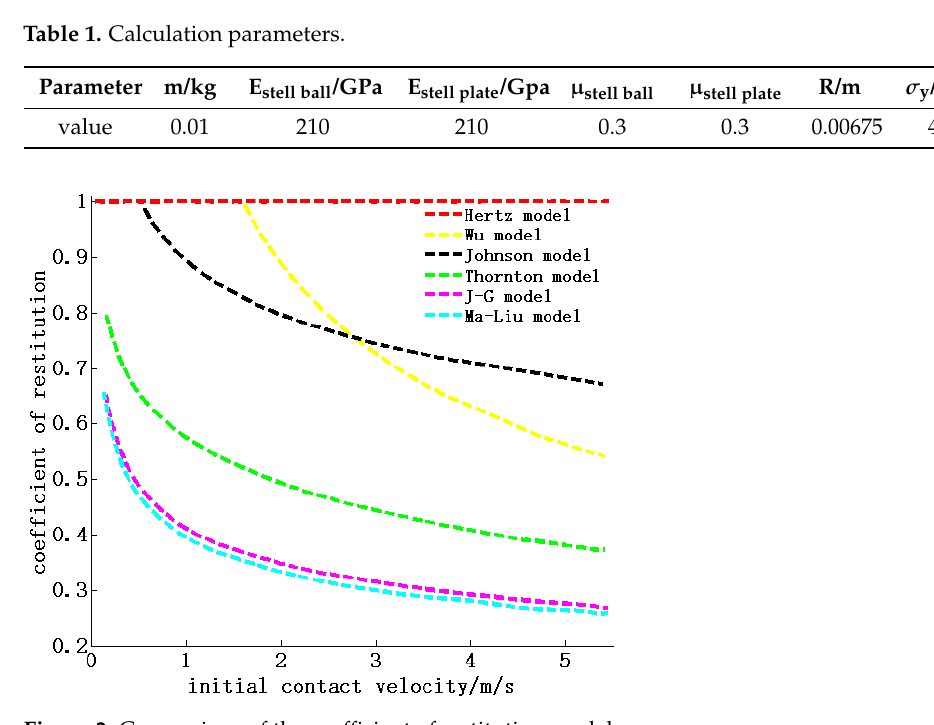
Figure 1. Classic ball–plate collision model.